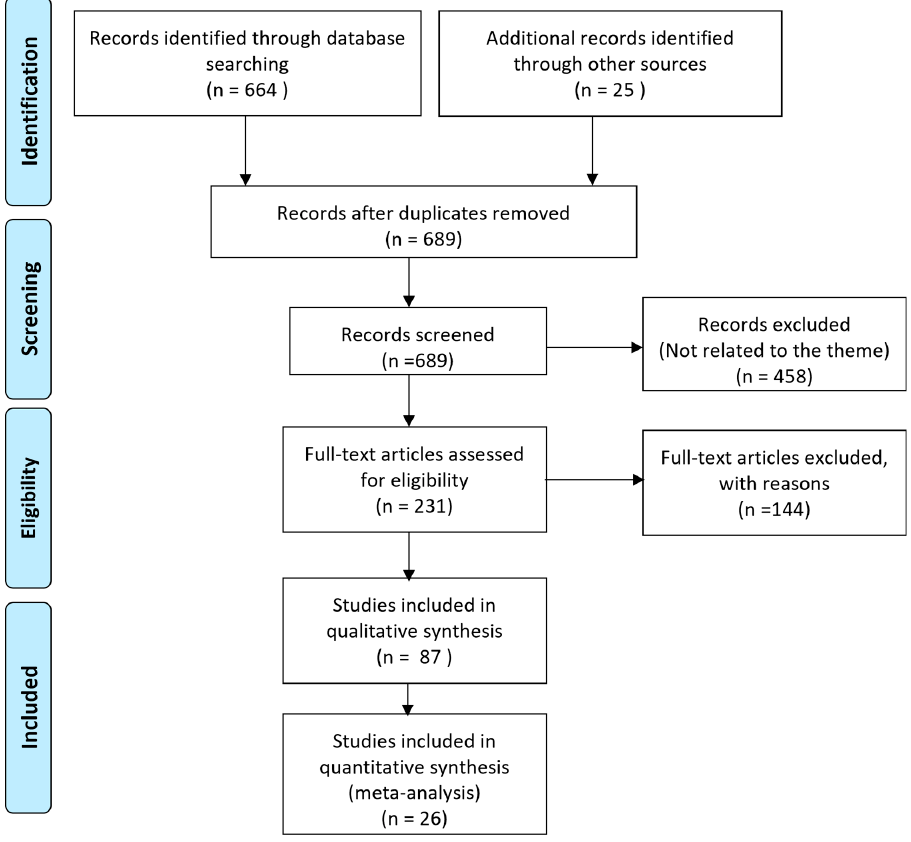
Figure 1. PRISMA